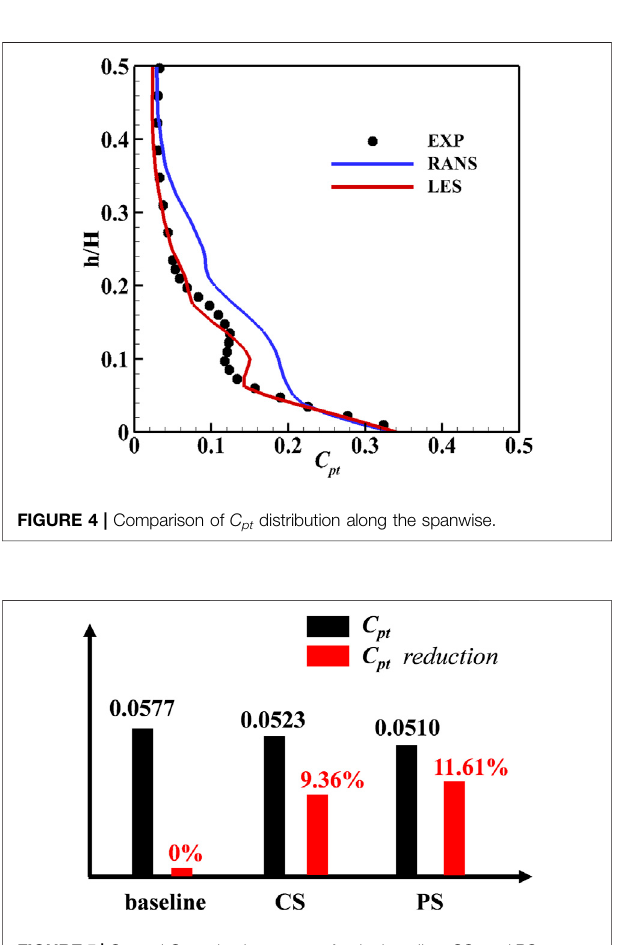
FIGURE 5 | C pt and C pt reduction percent for the baseline, CS, and PS. FIGURE 6 | Vortex structures and loss contour on the plane 20% c x downstreamofthetrailingedge( Q = 5,000,000). (A) Baseline; (B) CS; (C)